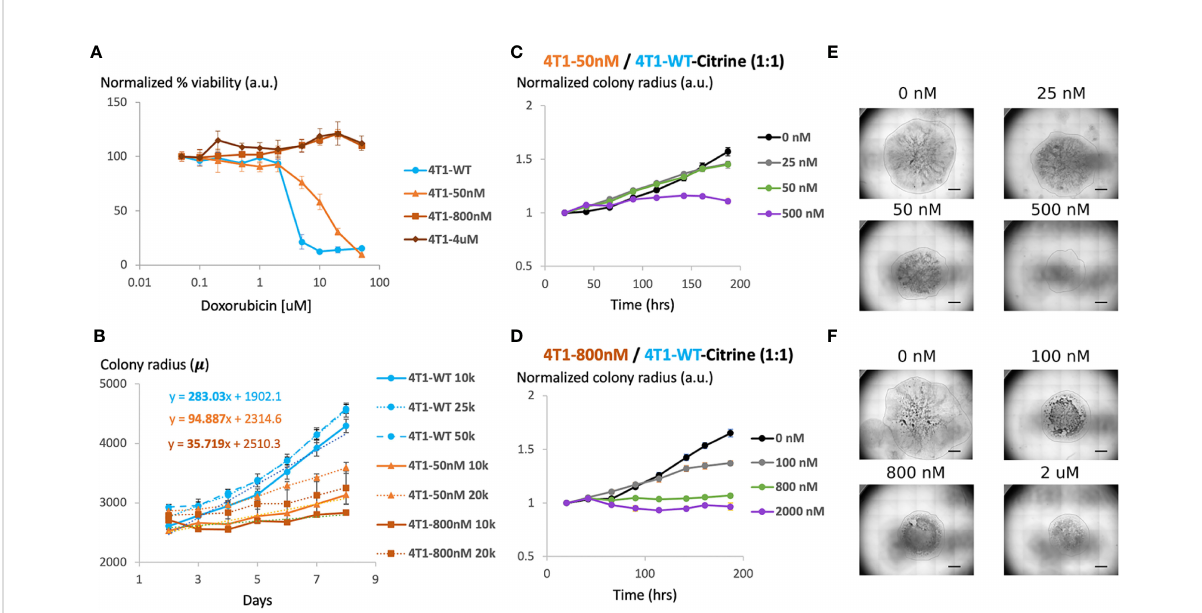
FIGURE 2 Generation and characterization of doxorubicin-resistant 4T1 cells in a 2D model system (A) Viability of chemosensitive or Dox-resistant 4T1 cells across varied Doxorubicin added to culture determined by MTT assay. Error bars represent standard deviation for 3 replicates. (B) Radial growth of chemosensitive and Dox-resistant colonies as a function of time for various seeding densities. (C) Colony radius normalized to starting radius in a 1:1 seeded mixture of sensitive and 50nM Dox resistant cells in the presence of 0 nM, 25 nM, 50 nM or 500 nM doxorubicin. (D) Colony radius normalized to starting radius in a 1:1 seeded mixture of sensitive and 800nM Dox resistant cells in the presence of 0 nM, 100 nM, 800 nM or 2 µM doxorubicin. (E, F) Stitched 4X bright fi eld images demonstrating size of colony and morphology across various seeding and chemotherapy conditions in (C, D) , respectively. Scale bar = 1000 µm. Number of replicates, n = 3, and the standard error is calculated with standard deviation divided by the square root of